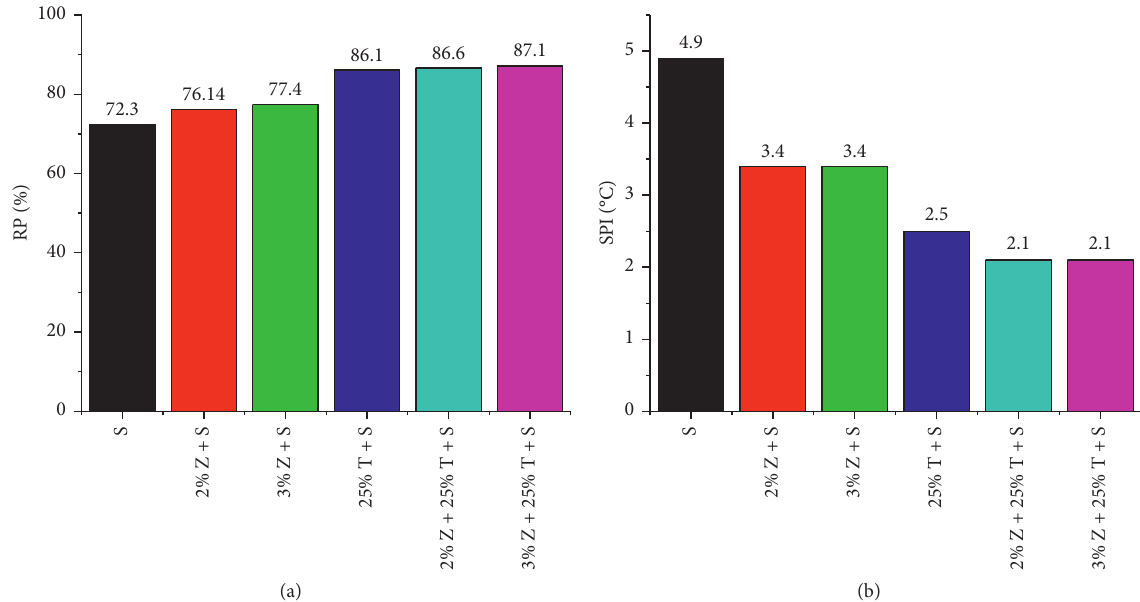
Figure 2: Effect of different content of nano-ZnO (Z) and TLA (T) on physical properties of SBS asphalt (S) after short-term aging. (a) Residual penetration for asphalt. (b) Softening point increment for